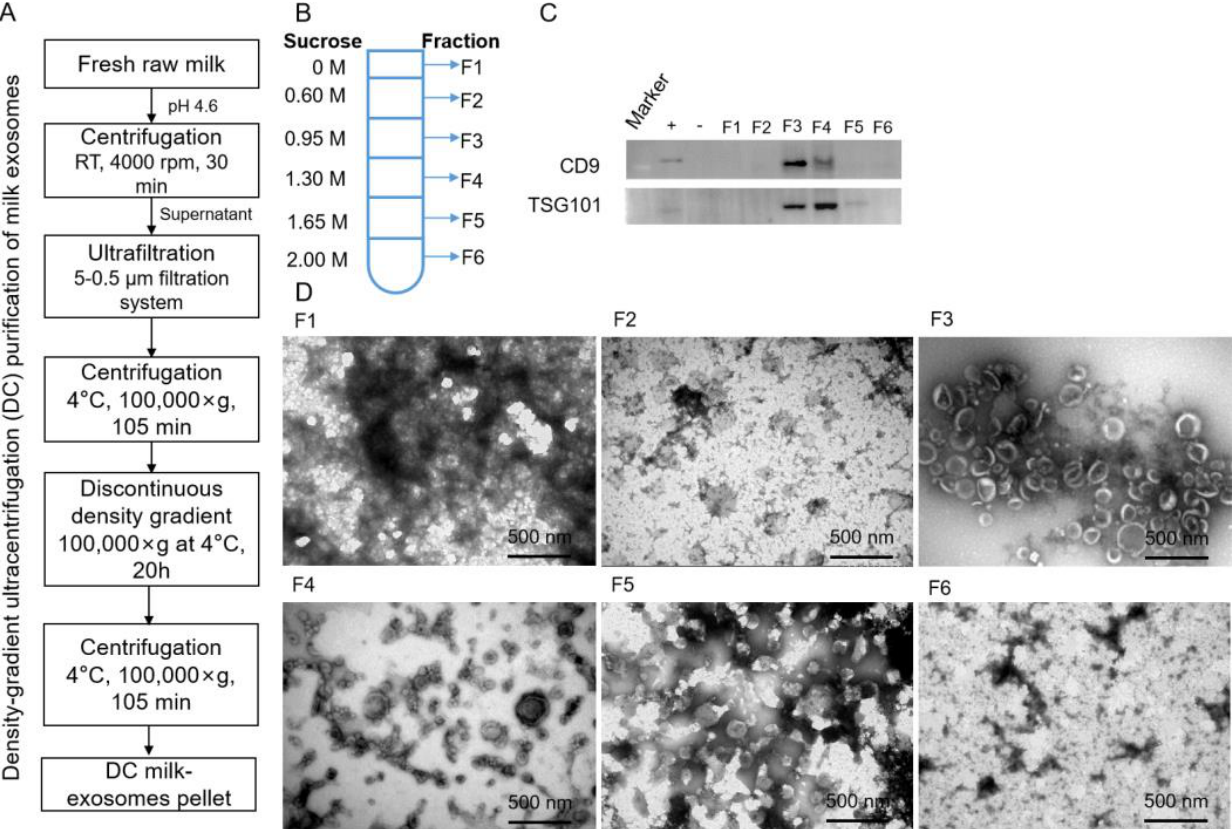
Figure 1. Identification of bovine-milk-derived exosomes in fractions of density gradient ultracen- trifugation. ( A ) Schematic representation of the major steps involved in isolating exosomes from bovine raw milk. ( B ) F1–F6 represents the corresponding concentrations of sucrose. ( C ) The exosome suspension was analyzed via Western blot. Immunoblots showed exosome markers in different milk exosome fractions. +, positive control (the protein of HaCat cells); − , negative control (the protein of Hela cells). ( D ) The morphologies of different fractions obtained via TEM. Scale bars = 500 nm.